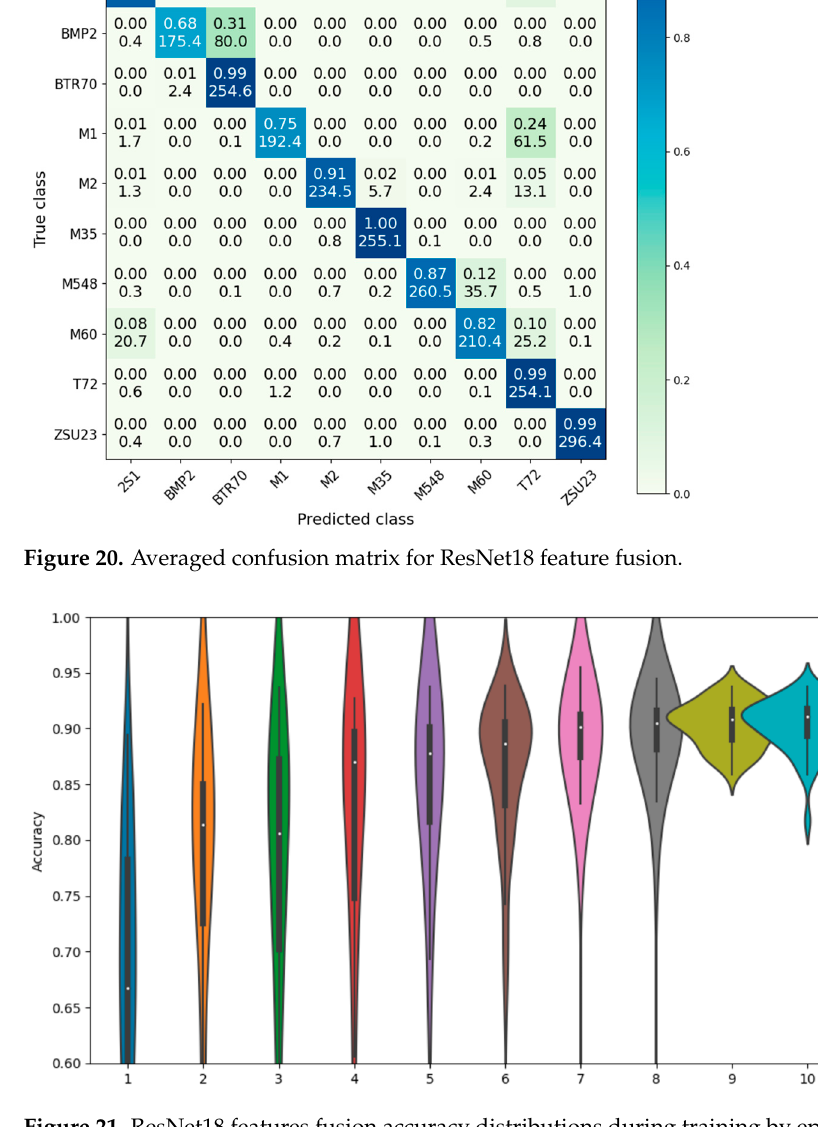
Figure 21. ResNet18 features fusion accuracy distributions during training by epoch. Table 9. ResNet18 feature fusion intraclass variance (Var) and standard deviation